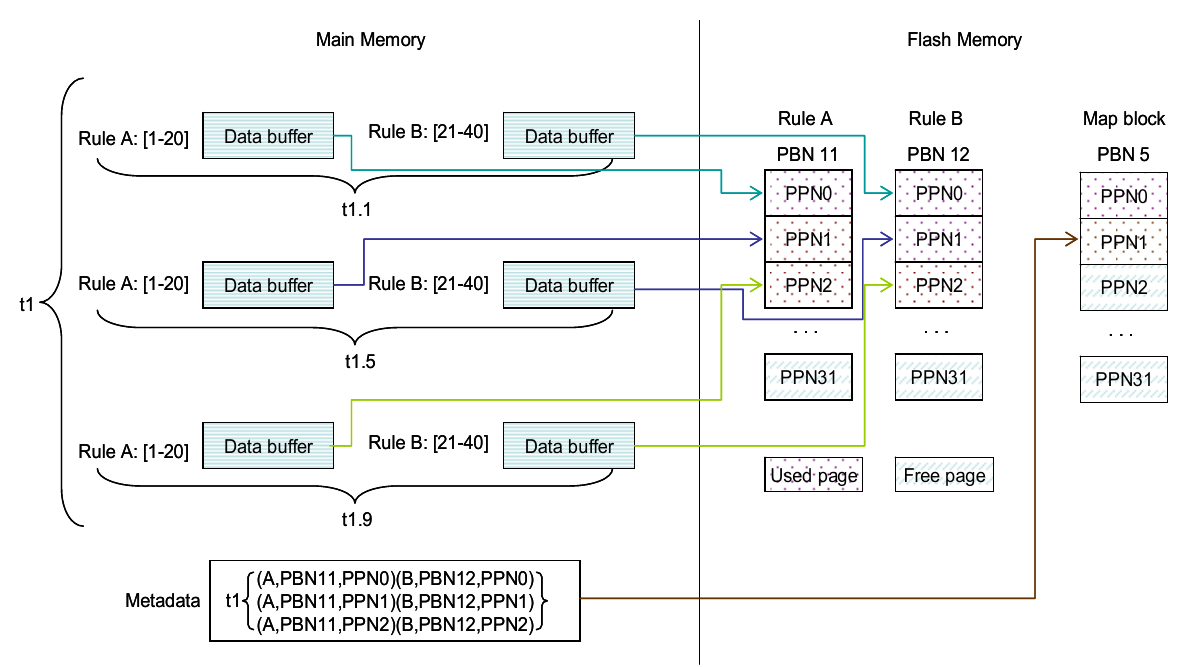
Figure 6. Metadata storage on flash map